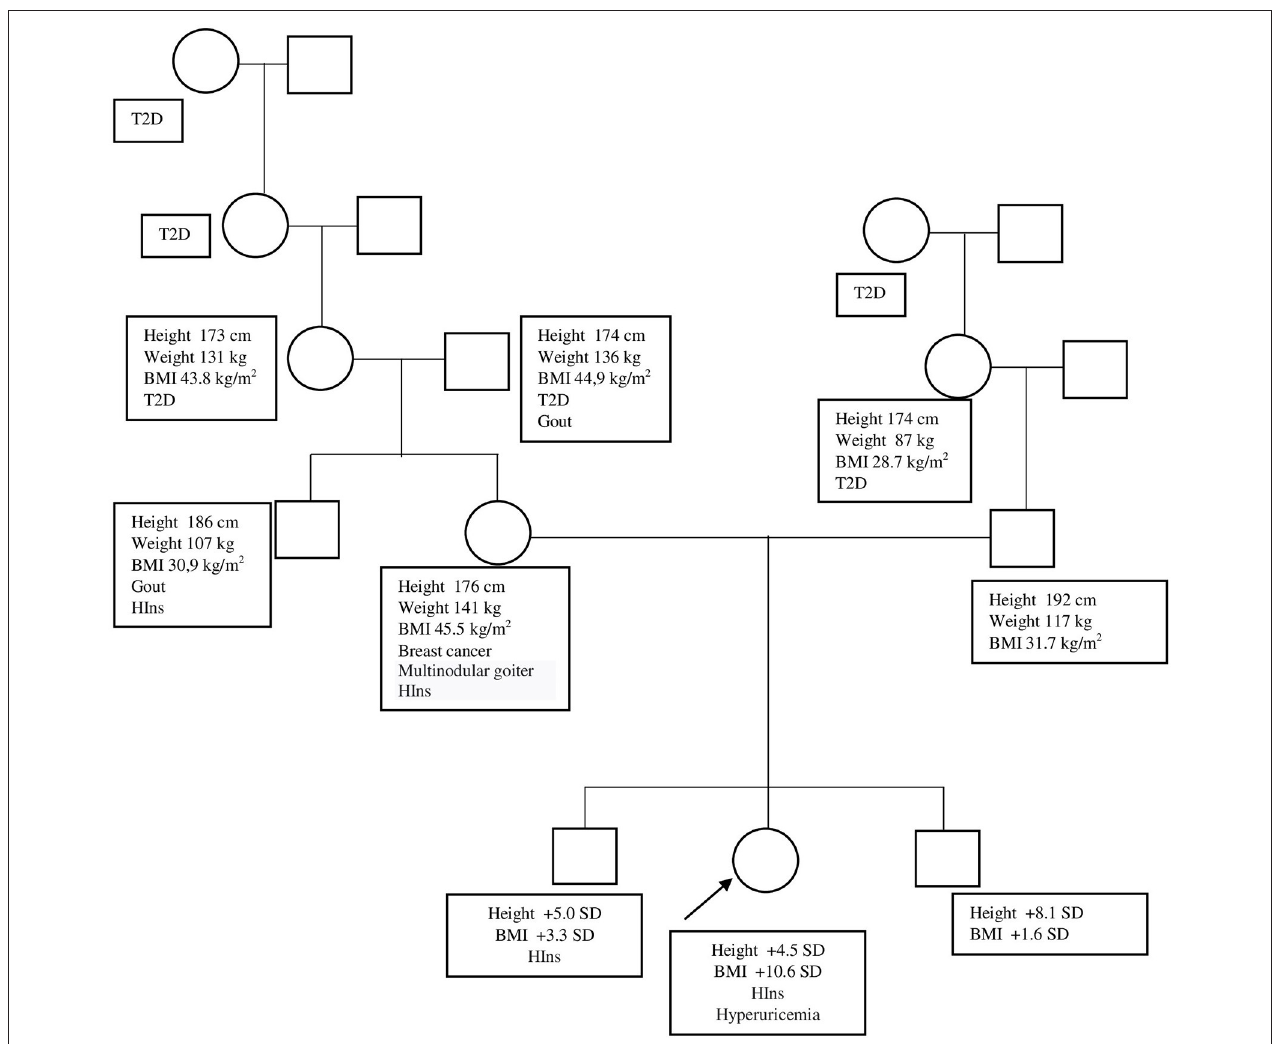
FIGURE 3 | Patient’s genealogic tree. BMI, body mass index; HIns, hyperinsulinism; SD, standard deviation; T2D, type 2